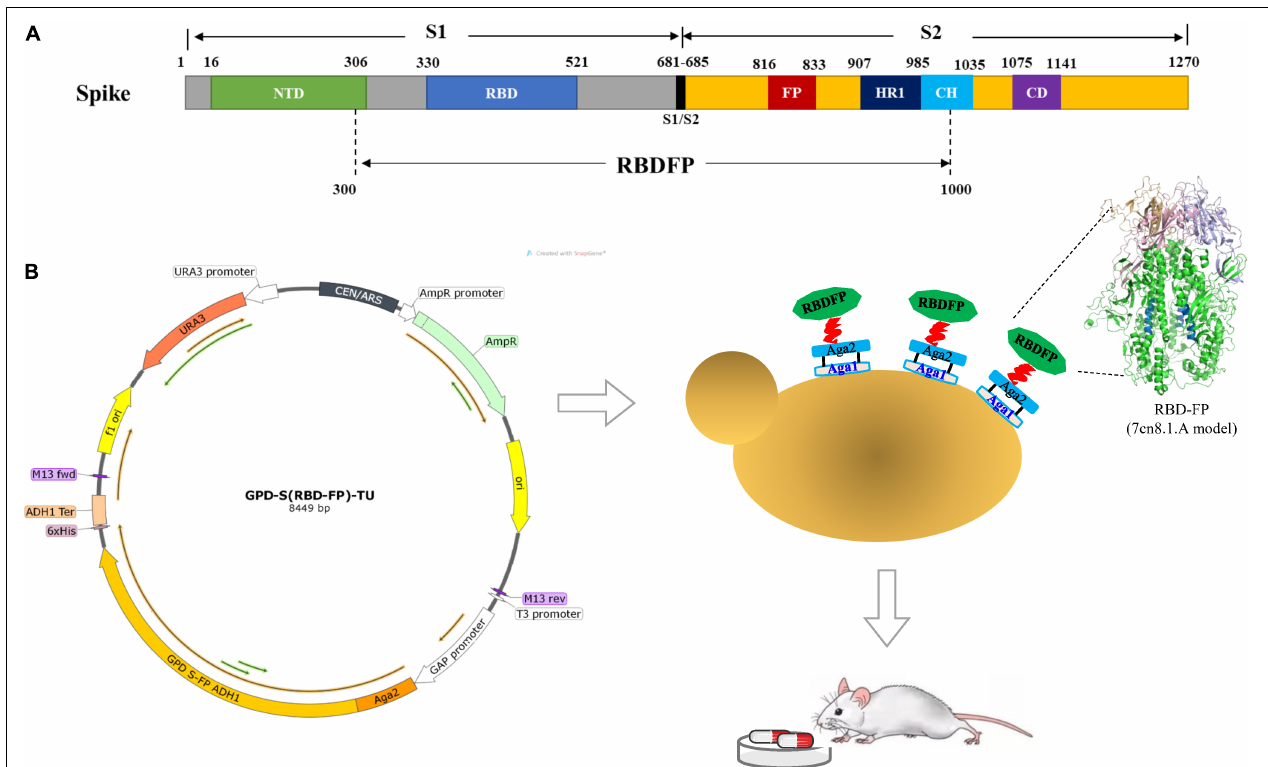
FIGURE 1 | Construction of spike S [receptor-binding domain (RBD)-fusion peptide (FP)] expression vectors. (A) Schematic diagram of severe acute respiratory syndrome coronavirus 2 (SARS-CoV-2) spike protein expression construct. (B) Diagram of the chromosomal region, including the S (RBD-FP) transcriptional unit with GAP promoter and ADH1 terminator fused to the C-terminal of Aga2 for presentation on the yeast cell surface. The structure of RBD-FP subunit was predicted by SWISS-MODEL based on PDB 7cn8 as the